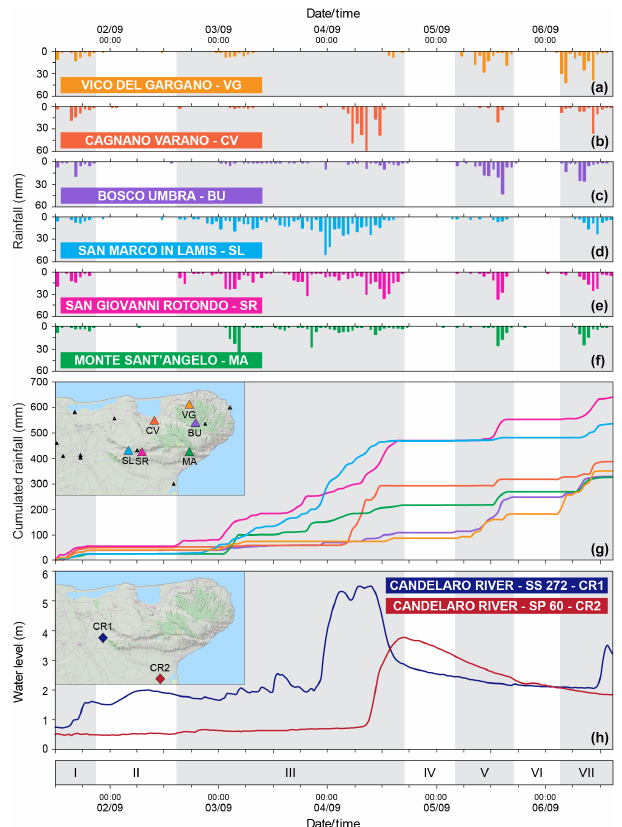
Figure 3. Rainfall and hydrological conditions for the period 1–6 September 2014 in the Gargano Promontory. (a–f) Hourly rainfall measurements for six rain gauges in the study area. (g) Cumulated rainfall for the same rain gauges; inset shows location of the rain gauges. (h) River water level at two gauging stations along the Can- delaro River; inset shows location of gauging stations. In the charts, shaded areas are rainfall (wet) periods (I, III, V, VII) and white areas are no-rainfall (dry) periods (II, IV,